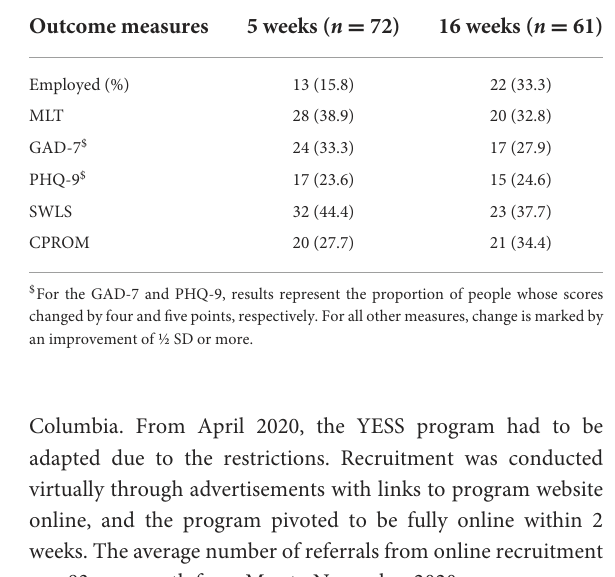
TABLE 1 Baseline characteristics of participants.